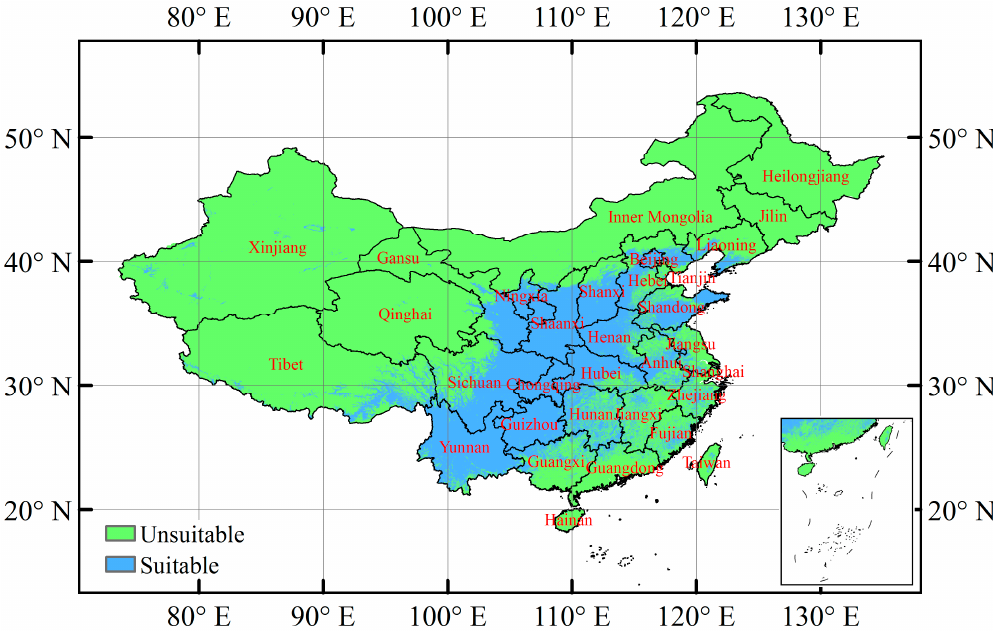
Figure 3. Current suitable climatic distribution of Juglans regia in China.